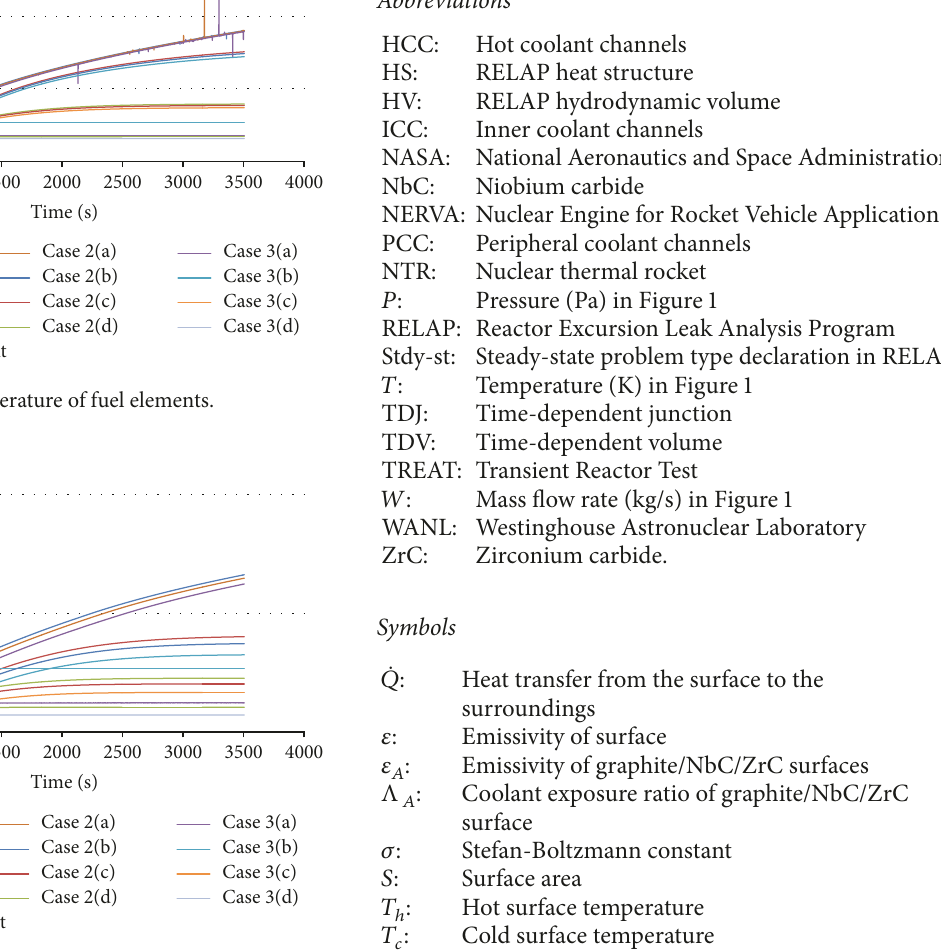
Figure 14: Material temperature of